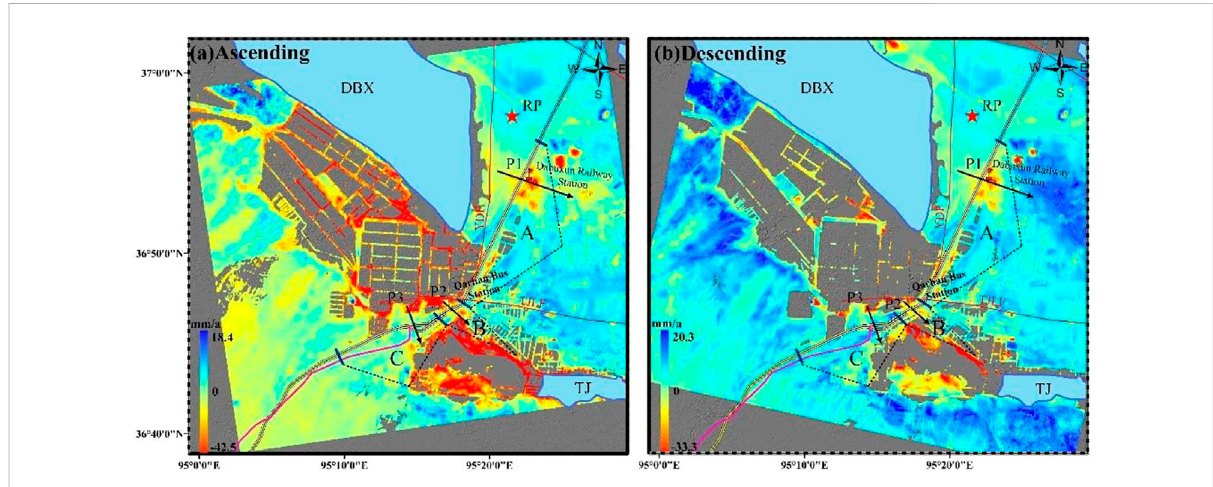
FIGURE 7 LOSAnnualaveragedeformationvelocitymapfrom2018to2022.Theredstarindicatesthereferencepointthatisselectedonastablearti fi cial structure. The dark blue short-terms represent the chainage break-point of the three different depositional segments (A, B, and C, mentioned in Figure 1). The black arrow lines P1 , P2 , and P3 denote the typical pro fi le lines of segments A, B, and C. The red lines denote the faults in this area. The red and yellow fl ags indicate the DRS and QBS, respectively.